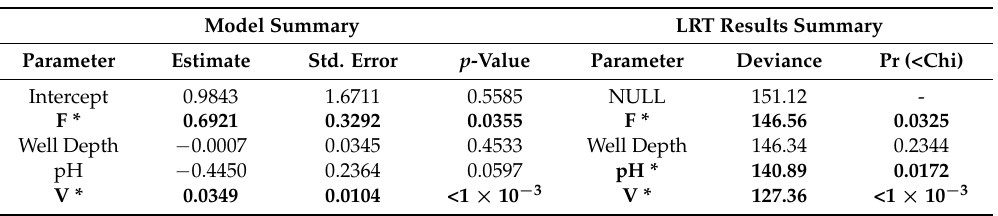
Table 3. Summary of the unconfined LR model (significant variables at p ≤ 0.05 are shown in bold and asterisk).